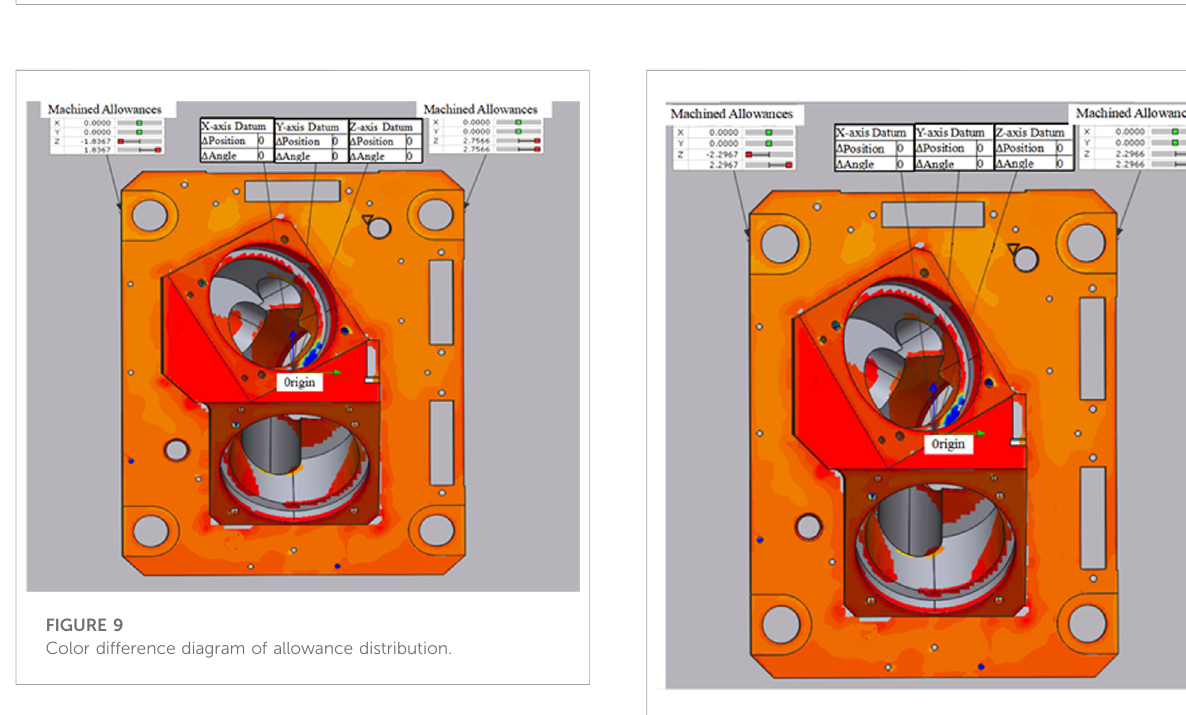
FIGURE 10 Software borrowing